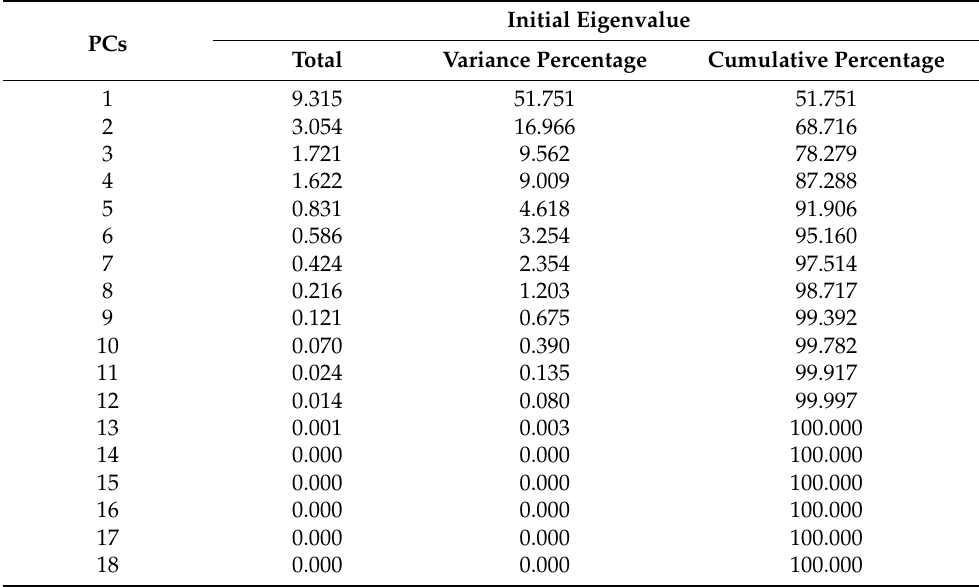
Table 2. Total variance explained by the factor